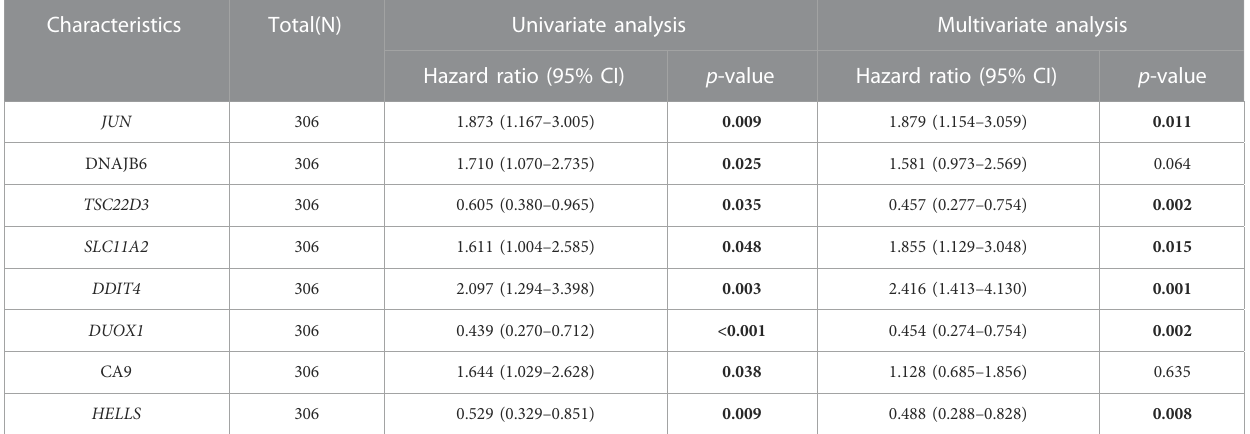
TABLE 1 Univariate/multivariate Cox regression analysis of